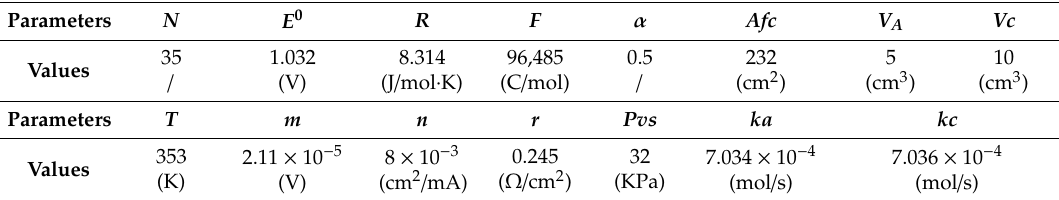
Table 6. PEMFC simulation parameters.